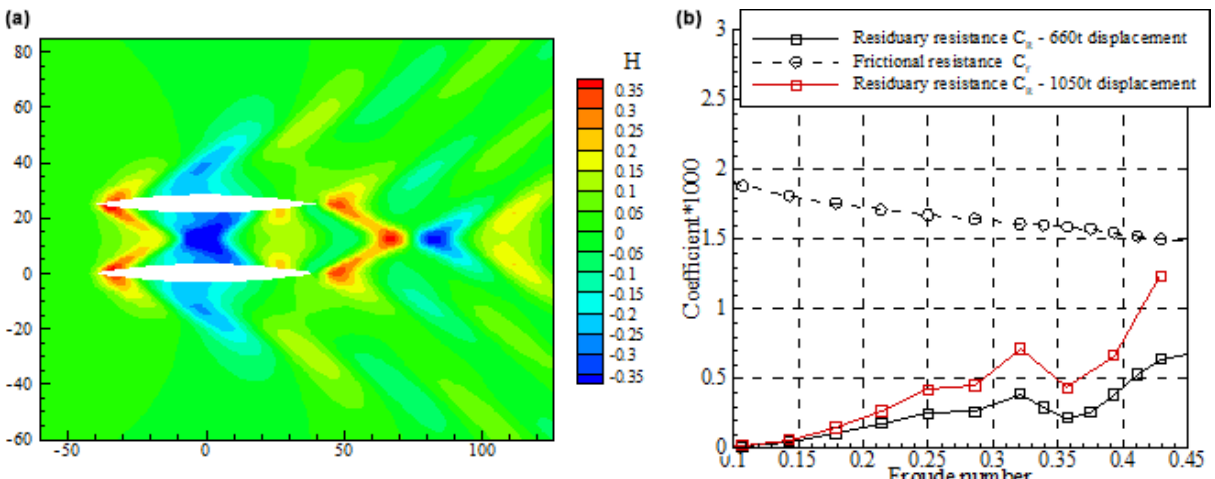
Figure 5. (a) Wave pattern around the ship hull of the updated design for a Froude number = 0.357 (10m/s ship velocity). (b) Hydrodynamic coefficients of the initial and updated